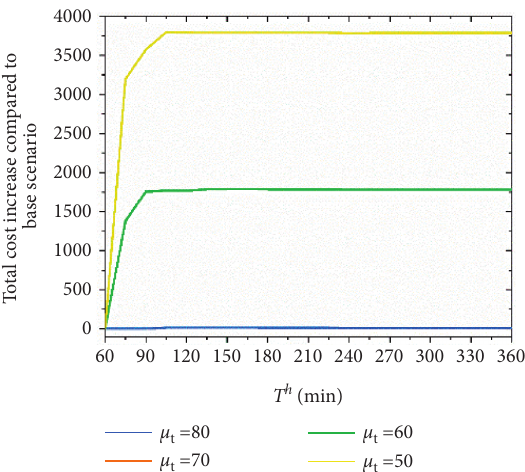
Figure 18: The total cost increases with different travel time